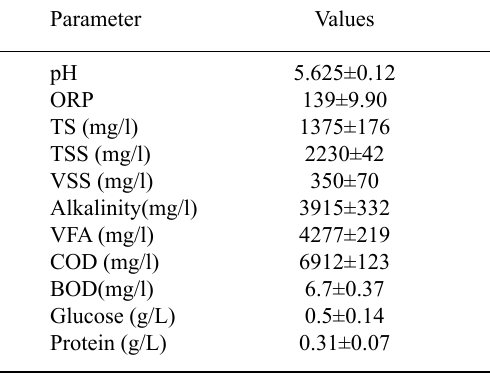
table 1. Characterization of effluent used as substrate for hydrogen